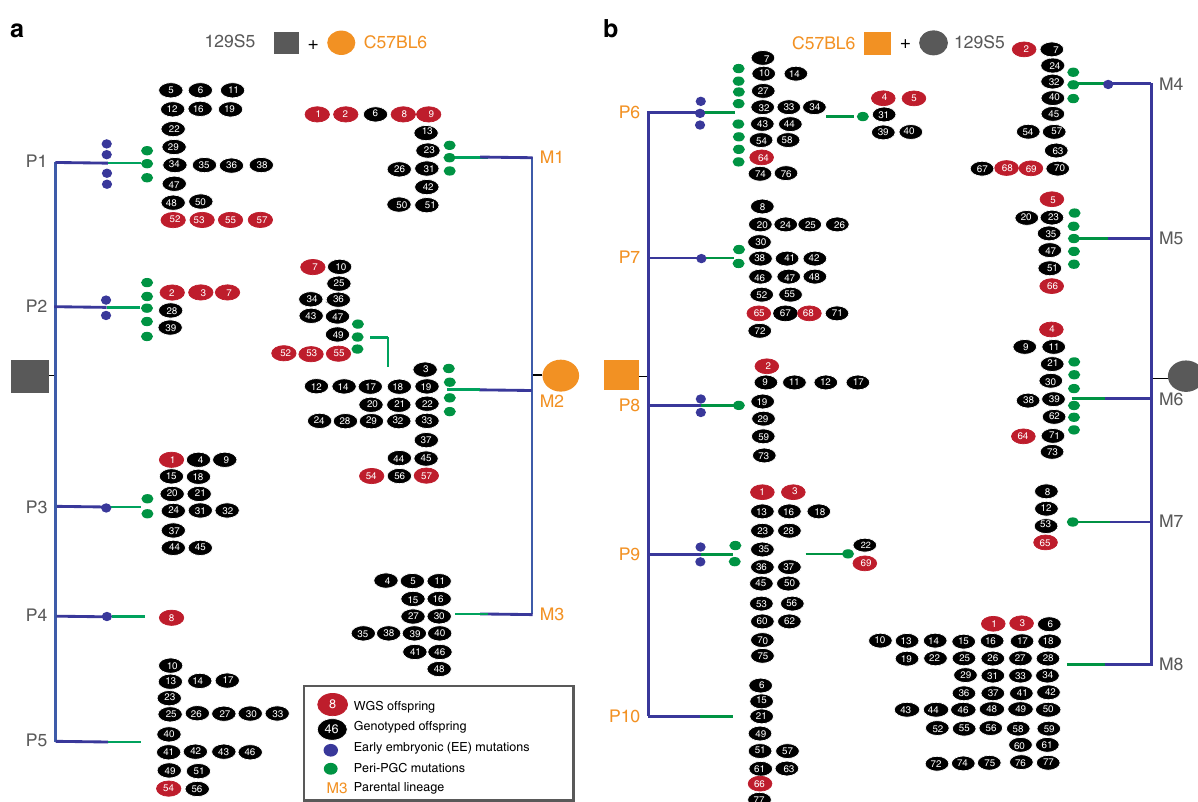
Fig. 6 Genealogies of maternal and paternal cell lineages delineated by early embryonic and peri-PGC mutations. Parental embryonic lineages reconstructed for each pedigree in the two largest pedigrees (CBGP8 (a) /GPCB2 (b) ), as paternal (P) or maternal (M), with each lineage numbered. Mutations delineating the lineages are colour-coded according to their temporal strata as listed in Supplementary Data 1. WGS and genotyped offspring are shown as red and black numbered circles, respectively. Offspring are numbered and ordered according to litter; for example, in lineage P2, individuals 2, 3 and 7 belong to the same litter, whereas numbers 28 and 39 arose in separate, later litters. Lineages P5, M3, M8 and P10 represent offspring without shared mutations and may contain several uncharacterised lineages. Minimal lineages for the four smaller pedigrees can be found in Supplementary Fig.